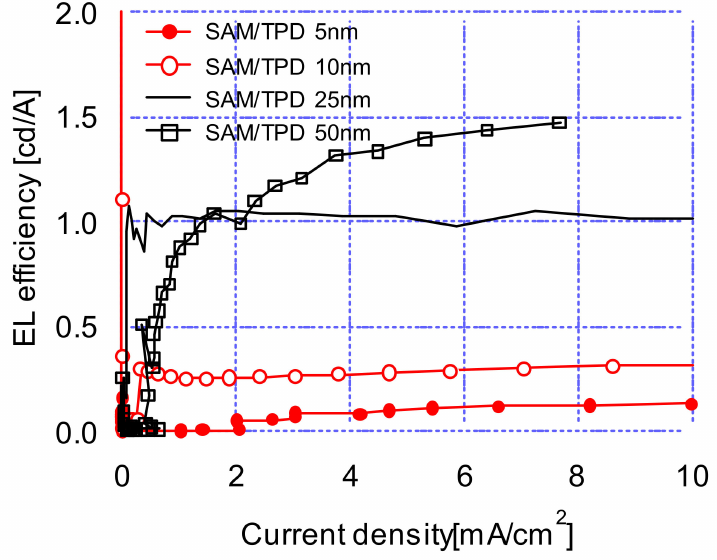
Figure 5. Current efficiency–current density characteristics of OLED devices at 5, 10, 25, 50 nm TPD thicknesses.